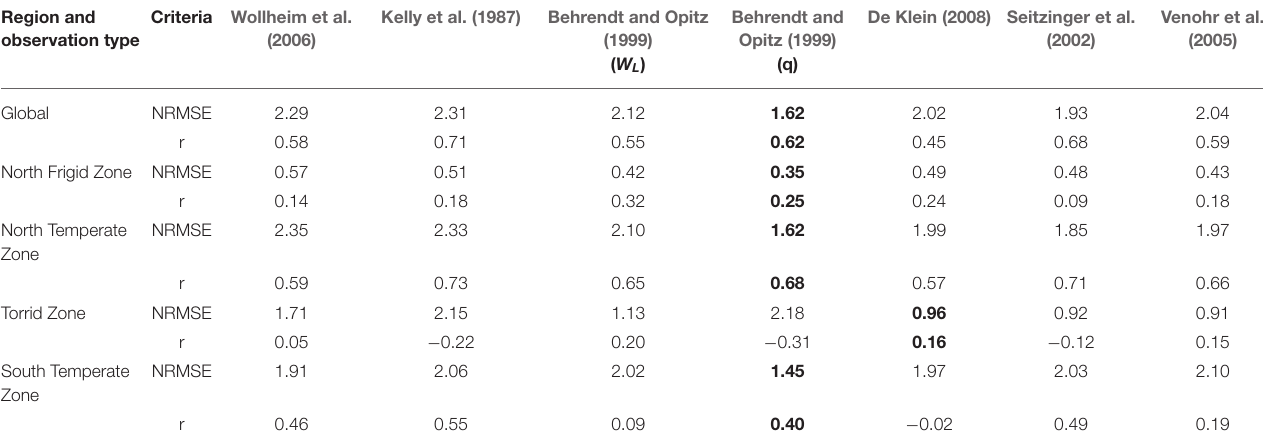
TABLE 2 | Assessment of the performance of N retention models for rivers. Region and Criteria Wollheim et al. observation type (2006)